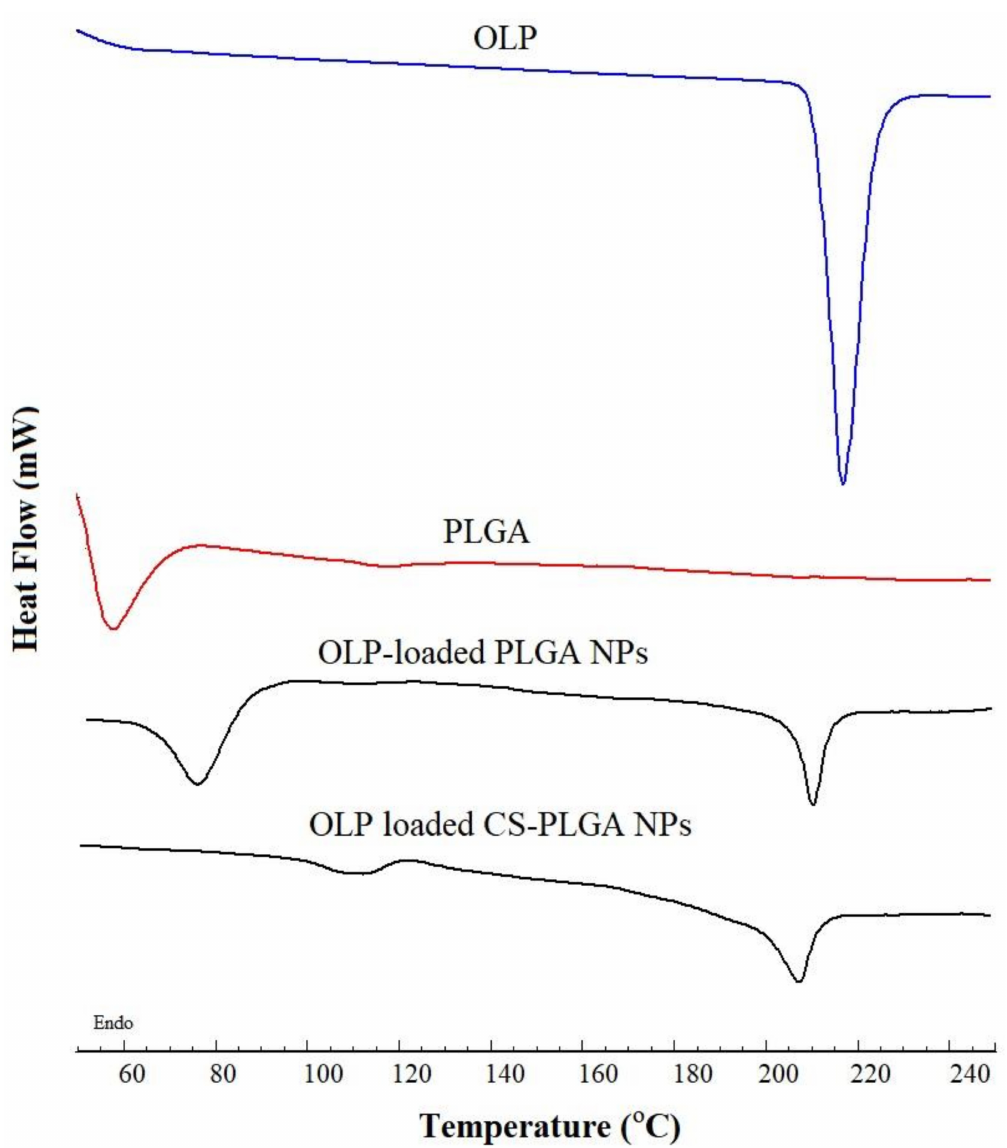
Figure 2. Comparative DSC spectra of pure OLP and their developed